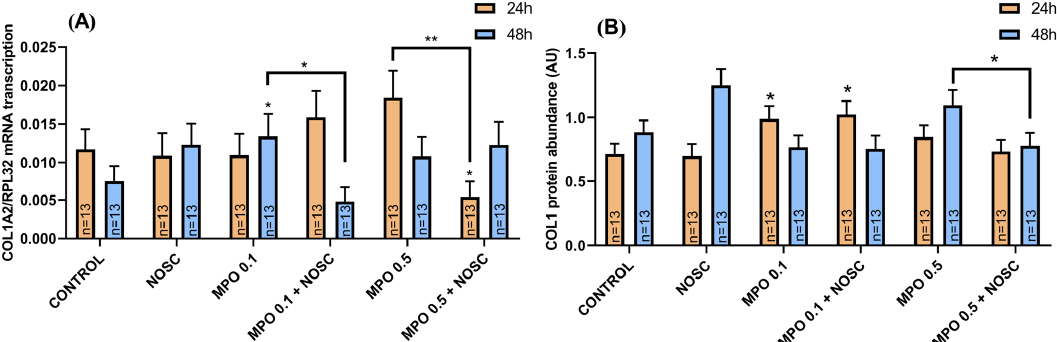
Figure 2. Effect of myeloperoxidase (MPO; 0.1–0.5 μg/mL), noscapine (NOSC; 45 μg/mL), or MPO (0.1–0.5 μg/mL) + NOSC (45 μg/mL) treatments on relative collagen type I alpha 2 chain ( COL1A2 ) mRNA transcription ( A ) and collagen type I (COL1) protein relative abundance ( B ) in equine endometrial explants treated for 24 h or 48 h, regardless of the estrous cycle phase. Results are shown as the least square means ± SEM and considered significant at p < 0.05. Asterisks represent significant differences relative to the respective control group. Asterisks above the connecting line represent significant differences between treatments (* p < 0.05; ** p < 0.01).